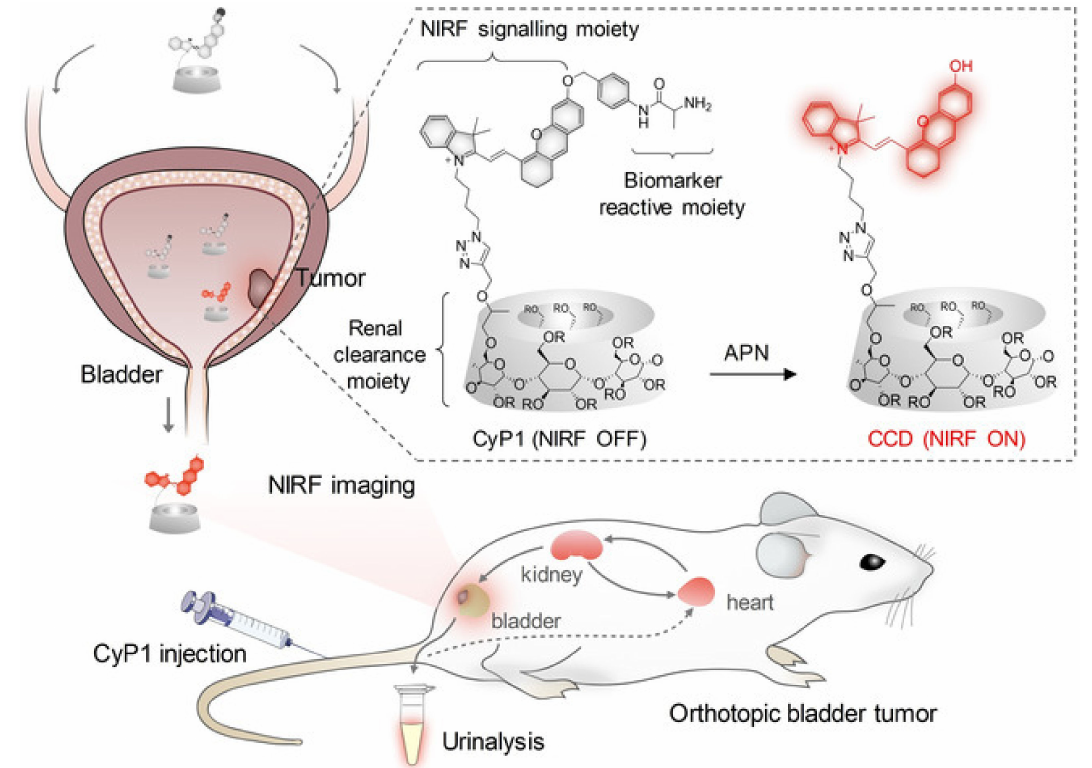
Figure 5. Scheme representing the design and mechanisms of the renal-clearable macromolecular reporter (CyP1) for NIRF imaging and urinalysis of BC in living mice. Chemical structures of CyP1 and its activated form as CCD in response to APN (R = H or CH 2 CHOHCH 3 ) are also represented. Huang et al.: A Renal-Clearable Macromolecular Reporter for Near-Infrared Fluorescence Imaging of Bladder Cancer. Angewandte Chemie. 2020. 59. P. 4416. Copyright Wiley-VCH GmbH. Reproduced with permission